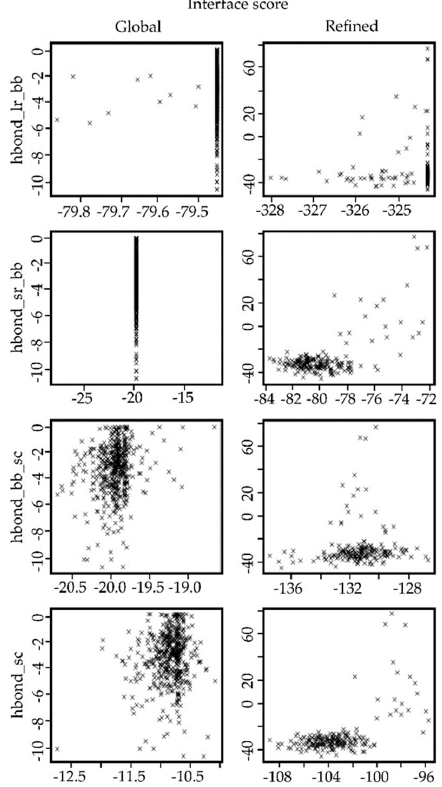
Figure 3. Comparison of different terms in the score file registered for the complexes created using the global protein–protein protocol versus the values obtained for the models created using the FlexPepDock protocol. hbond_lr_bb = energy of long-range hydrogen bonds (kcal/mol), hbond_sr_bb = energy of short-range hydrogen bonds (kcal/mol), hbond_bb_sc = energy of backbone–side-chain hydrogen bonds (kcal/mol), and hbond_sc = energy of side-chain–side-chain hydrogen bonds (kcal/mol).